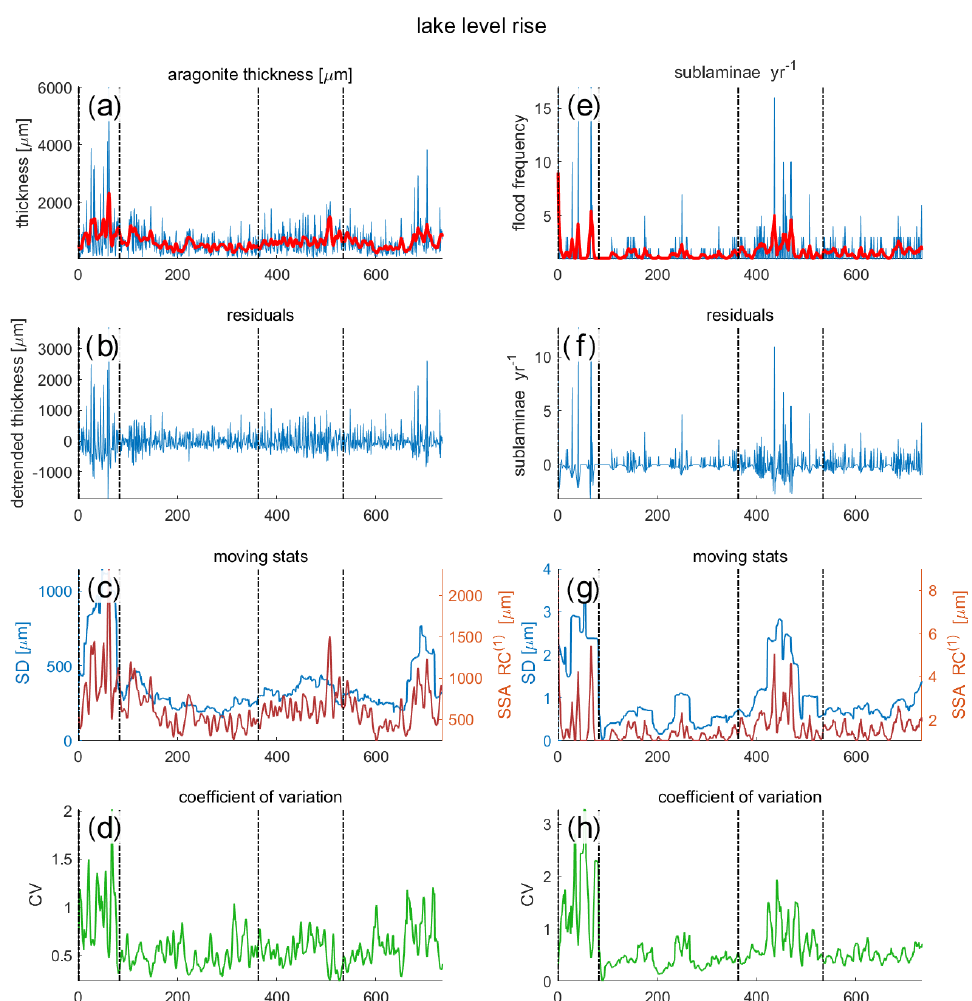
Figure 11. Running statistical properties of aragonite lamina thickness (a–d) and flood frequency (e–h) for the studied lake-level rise. The measured data (a, e) , the residuals (after subtracting the RC (1) ) (b, f) , RC (1) and running standard deviation (30-year window) (c, g) , and the (d, h) coefficient of variation calculated as running SD RC (1)